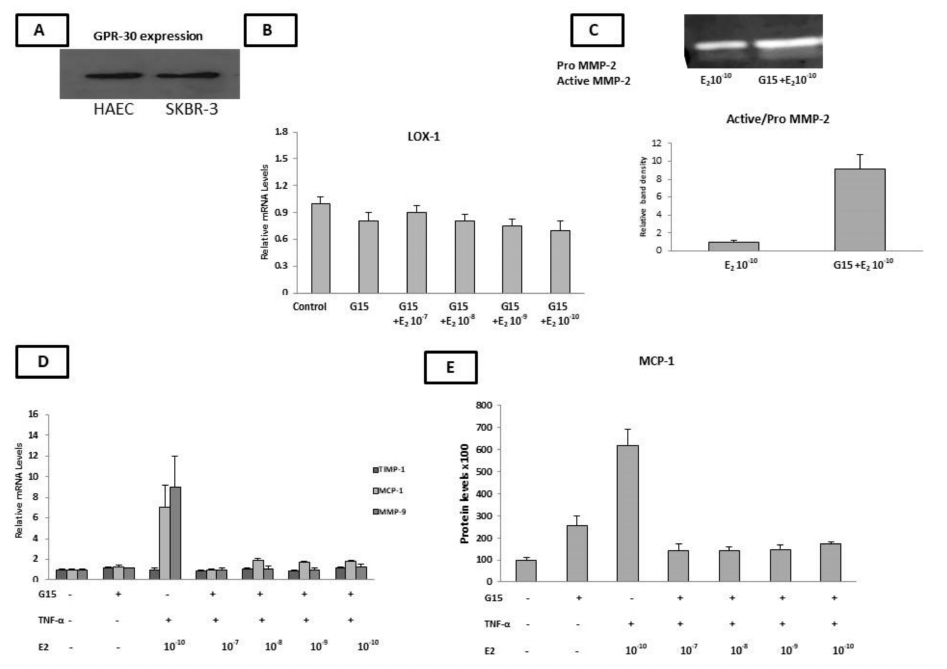
Figure 3. HAECs were co-incubated with G15 (GPR-30 antagonist) and various concentrations of E 2 in the presence/absence of low-grade inflammation (TNF- α ). ( A ) GPR-30 protein levels were detected by western blotting in HAECs. ( B ) Co-incubation of HAECs with G15 and E 2 reversed the E 2 -induced increase in LOX-1 mRNA levels (10 − 10 M of E 2 ). ( C ) Co-incubation of HAECs with G15 reversed the E 2 -reduced active/proMMP-2 ratio (10 − 10 M of E 2 ). ( D ) Pre-incubation of cells with TNF- α followed by the co-incubation of cells with G15 and various concentrations of E 2 reversed the (TNF- α + E 2 )-induced increase in TIMP-1, MCP-1, and MMP-9 mRNA levels. ( E ) Pre-incubation of cells with TNF- α followed by the co-incubation of cells with G15 and various concentrations of E 2 reversed the (TNF- α + E 2 )-induced increase in MCP-1 protein levels. The graphical data are represented as mean ± SD of at least three independent